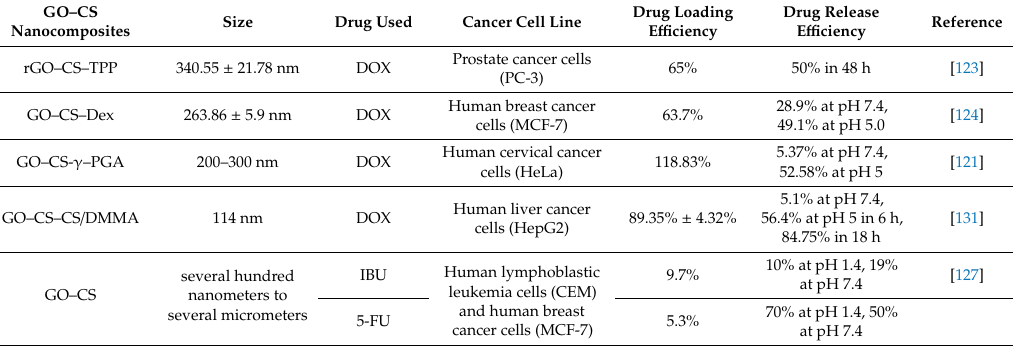
Table 1 the different GO–CS composites developed as nanocarriers for drug delivery in cancer therapy. Table 1. The graphene oxide (GO)–chitosan (CS) composites developed, the drug used, the type of cancer and cell treated, and the drug loading and release e ffi